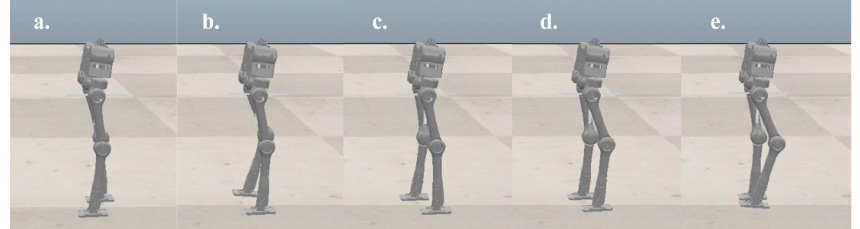
Figure 5. Five key frames of dynamic simulation. ( a ) The right supporting foot is taking off from the ground. ( b ) Right foot is swinging forward. ( c ) Right swing foot is touching down ( d ) Left foot is taking off from the ground. ( e ) The left foot is swinging forward.